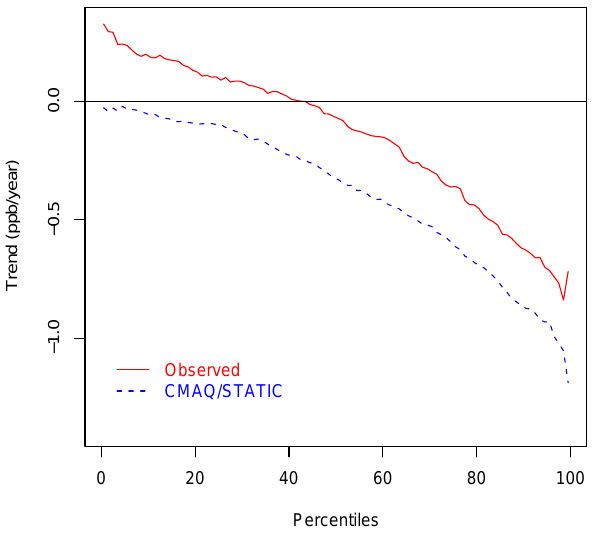
Fig. 7. Observed and CMAQ/STATIC least-squares trend estimates for 1988–2005 (y-axis) vs. percentiles of the May–September 8-h daily maximum ozone distribution. Trends were calculated sepa- rately at each of the 90 monitoring sites, the median trend across all sites is shown here.